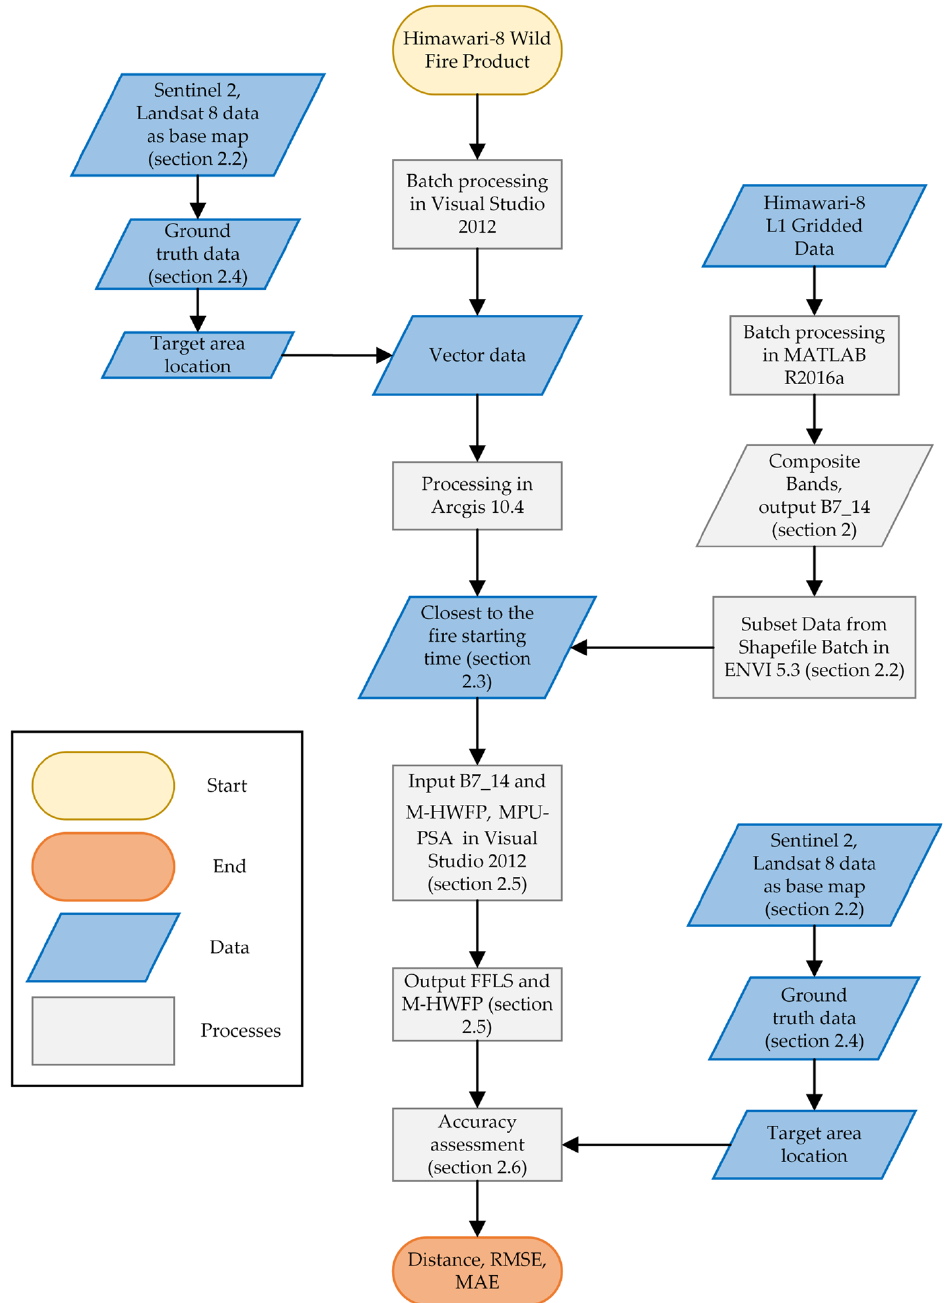
Figure 1. Flowchart of the analysis performed in the current study. M-HWFP represents modified Himawari-8 Wild Fire Product. MPU-PSA represents mixed-pixel unmixing integrated with pixel- swapping algorithm. FFLS represents forest-fire locations at subpixel. RMSE represents root mean square error. MAE represents mean absolute error.